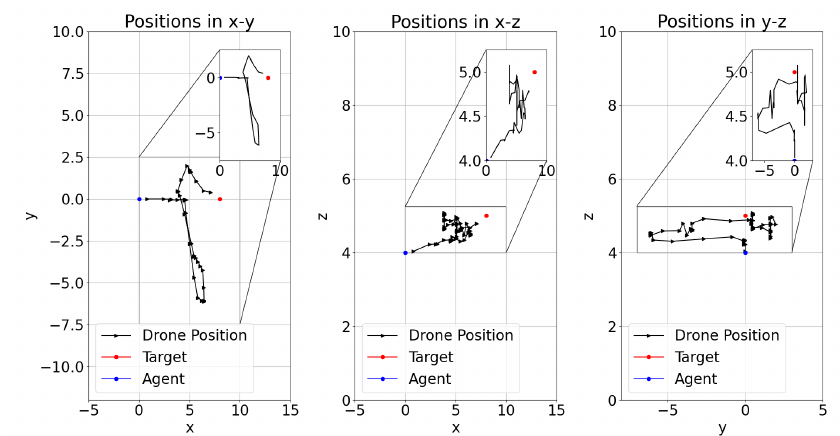
Figure 14. Model-2 Training Episode 3560 Drone Position.